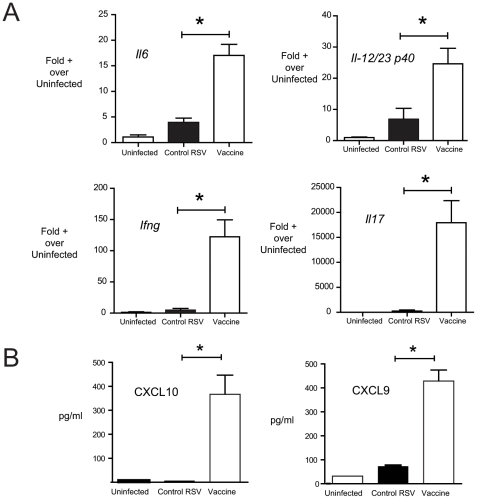
NE-RSV vaccination promotes early Th1/Th17-associated cytokines in the lungs.In (A), the levels of Th1/Th17-associated cytokines were assessed at day 4 post-infection via QPCR of lung RNA. In (B), the levels of CXCL9 and CXCL10 were assessed at day 4 post-infection via Bioplex multiplex assay of lung homogenates. Each column represents 5 mice per group, and the experiment was repeated with similar results. * = p<0.05.